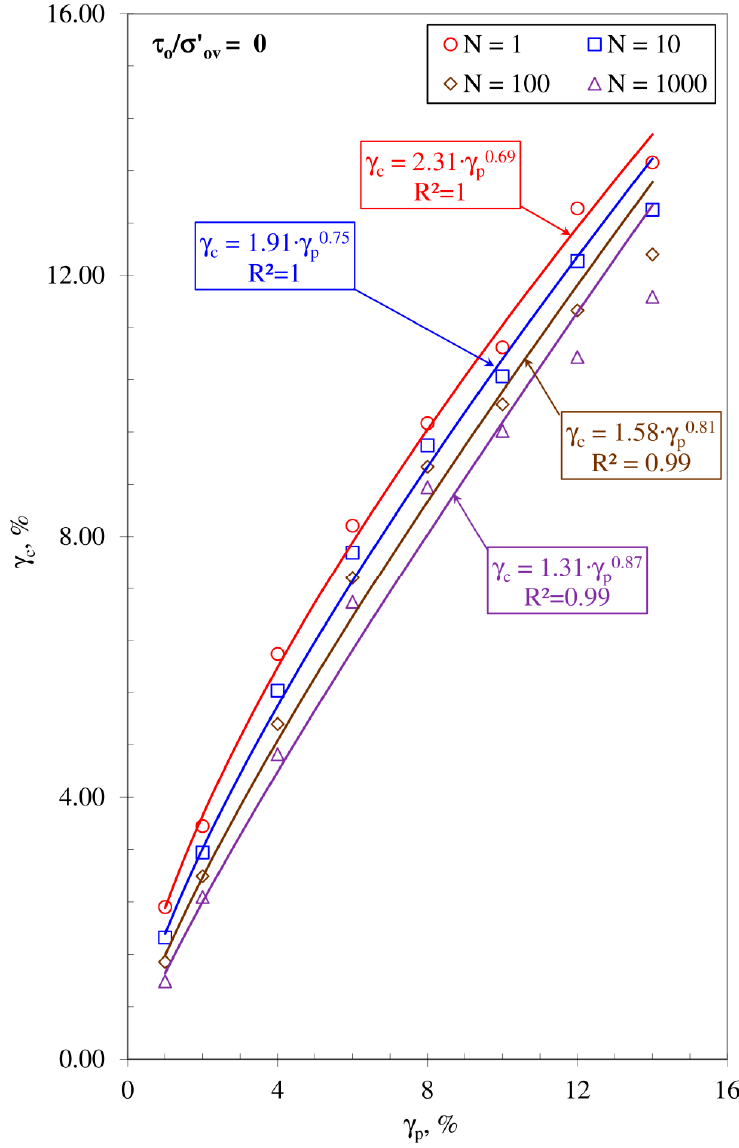
Figure 11. Vertical section in the graph of Figure 10 for values of N equal to 1, 10, 100, and 1000, corresponding to τ o / σ′ ov = 0.